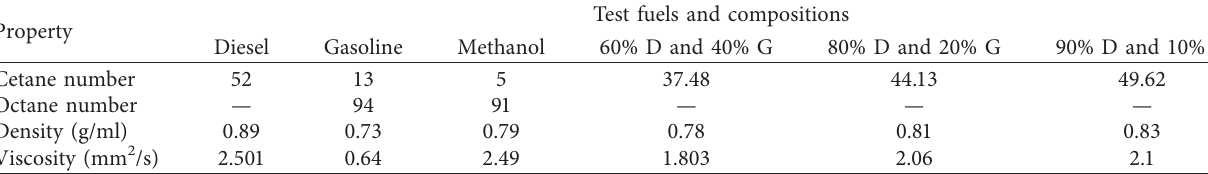
Table 2: Chemical and physical properties of the test fuels.